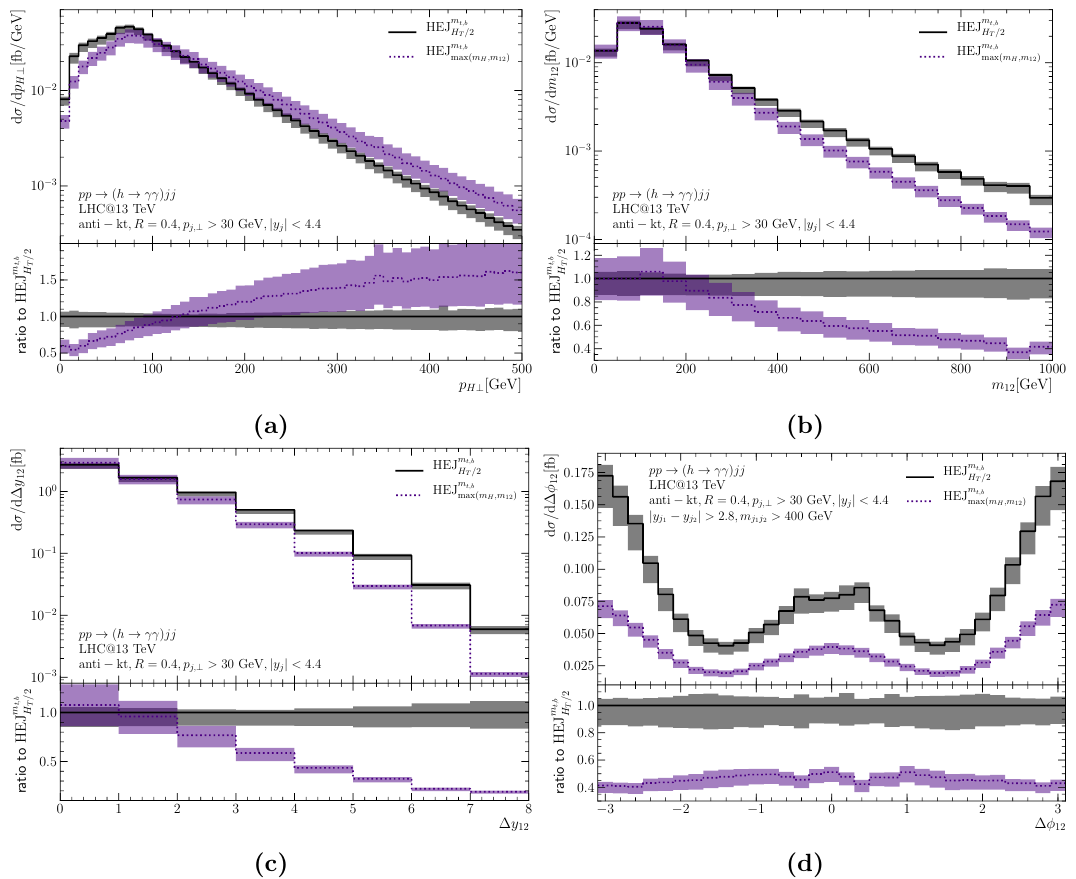
r = (cid:22) f = H T = 2 and